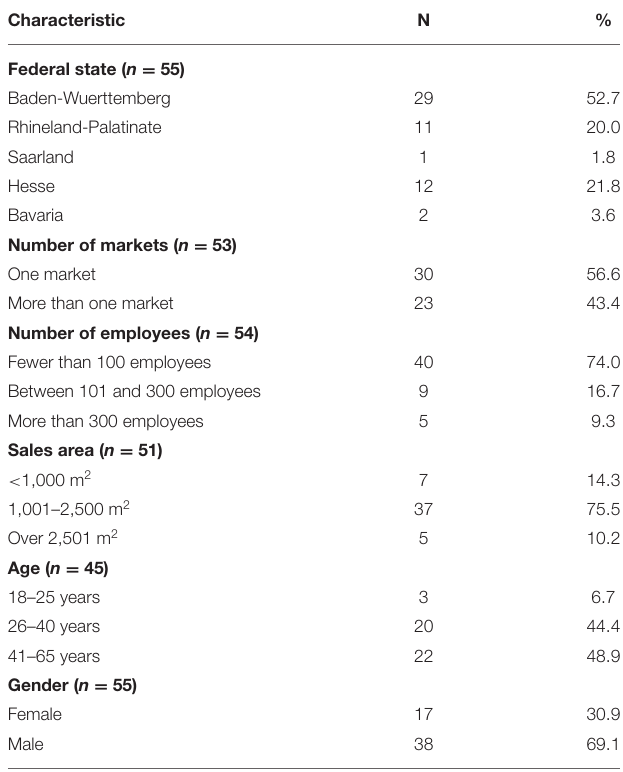
TABLE 2 | Characteristics of participating retailers in quantitative